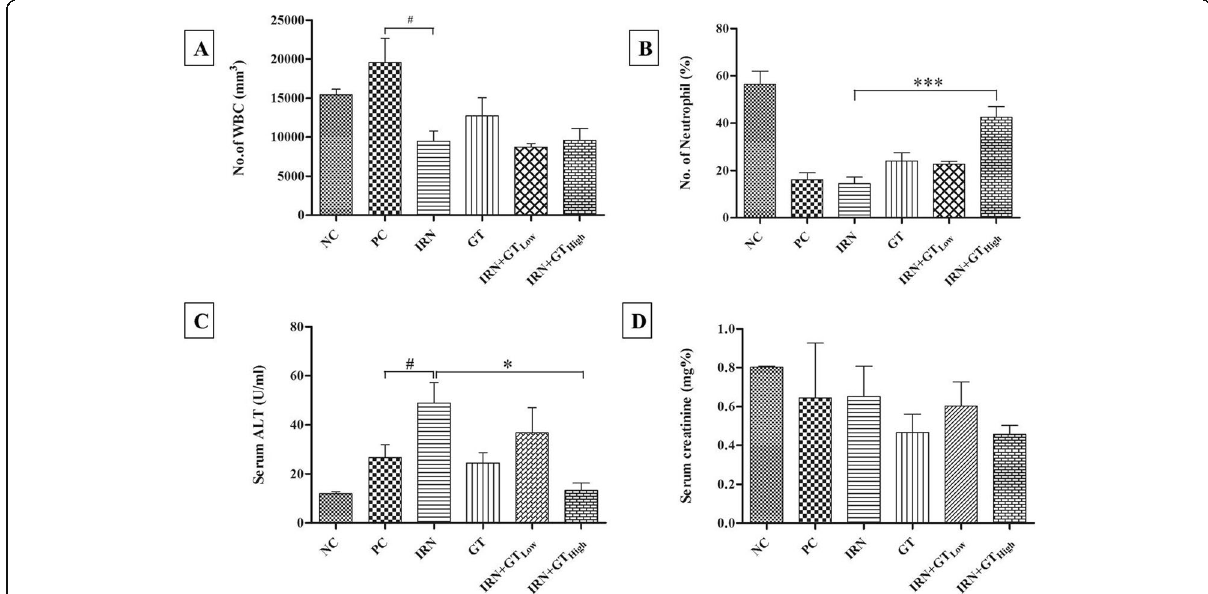
Fig. 5 Effect of IRN and GT on A total number of WBC, B percentage of neutrophil, C serum ALT, and D serum creatinine level during the 12- week treatment period. Values were presented as mean ± SEM, # p < 0.05, ## p < 0.01, and ### p < 0.01 when compared to the PC group and * p < 0.05, ** p < 0.01, and *** p < 0.001 when compared to the IRN group. Decrease in number of WBC was recorded in treated groups; however, decrease was recorded to be significant and maximum in the IRN group as compared to the PC group. Significant increase in number of neutrophil was recorded in the IRN+GT High group as compared to the IRN group. Significant increase in serum ALT level was recorded in the IRN group when compared to the PC group. ALT level was recorded to be less in the IRN+GT High group as compared to the IRN group. Decrease in serum creatinine level was recorded in treated groups; however, decrease was recorded to be maximum in the IRN+GT High